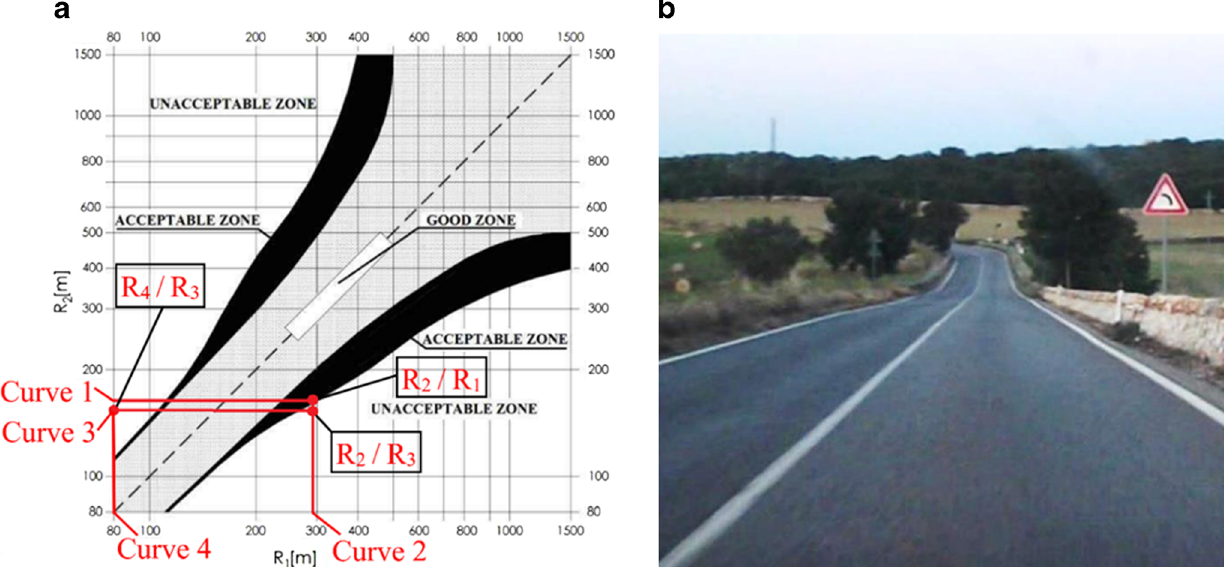
Fig. 10 Site PP1. a Bad consistency of the subsequent curves (1 to 4), based on the B Tulip ^ diagram in the Italian road standards. b Bad coordination of horizontal and vertical alignments at curve 3 (near a sag vertical